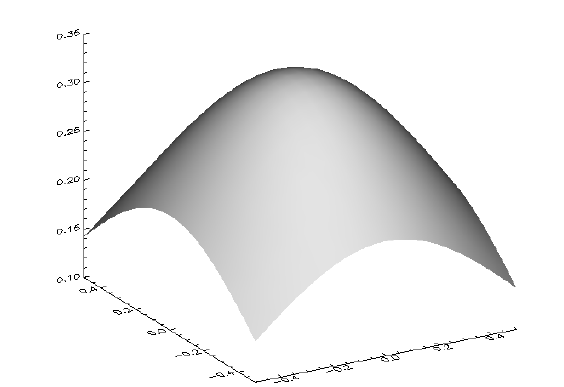
Figure 3 : Factor Fc function of the centering of the star in the sampling grid